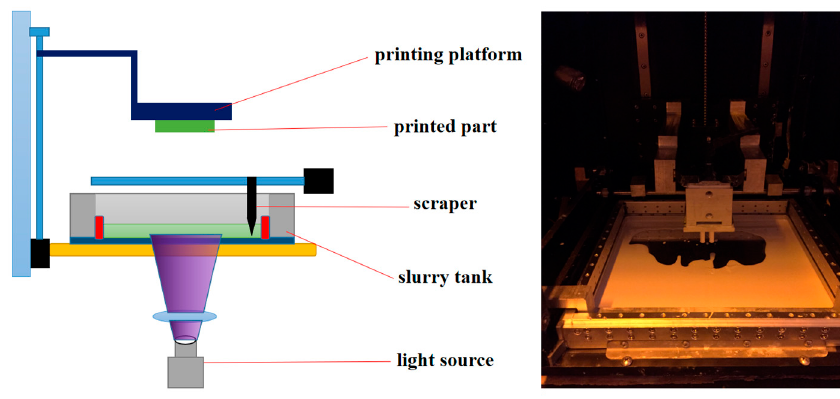
Figure 3. Schematic view of the printing process.